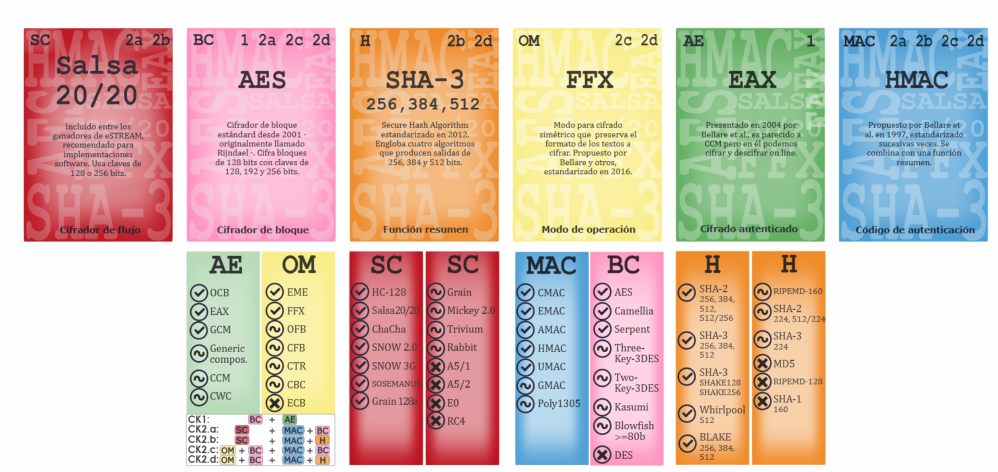
Figure 1. Crypto Go: card sample for each tool type and cheat cards.